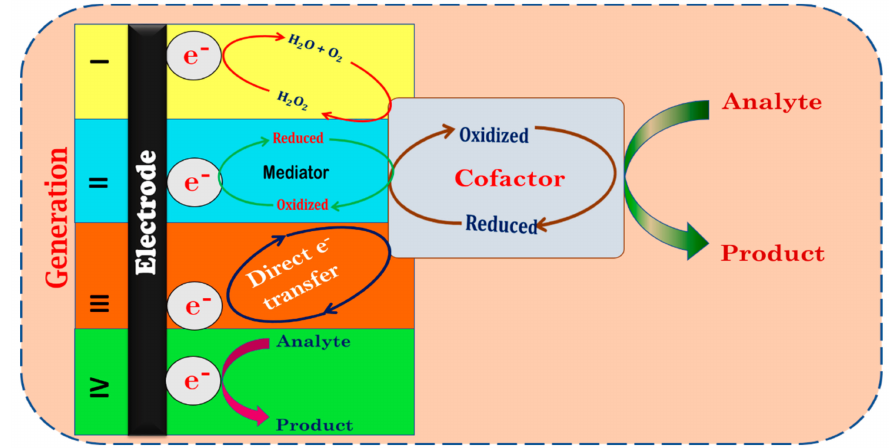
Figure 2. Schematic representation of various generations of electrochemical